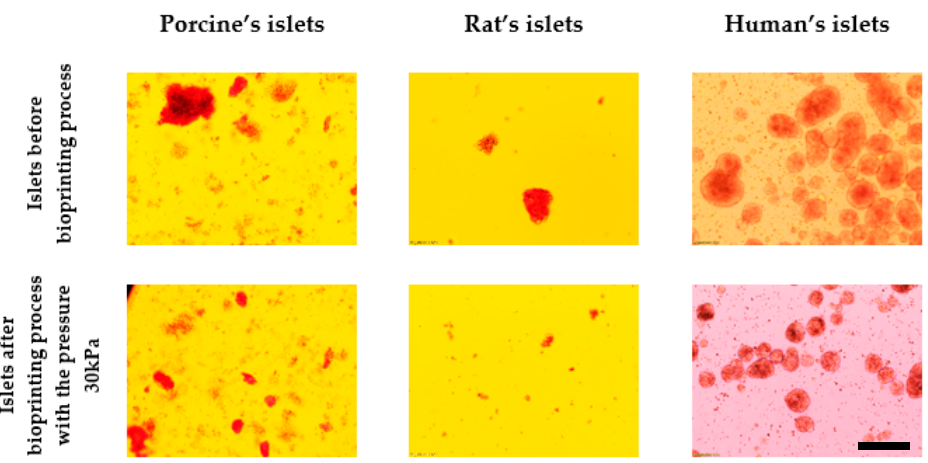
Figure 7. Comparison of the effect of pressure on the structure of pancreatic islets. Islets were stained by dithizone and observed under light microscopy. Nozzle with inner diameter 0.6 mm; scale: 200 μ m.